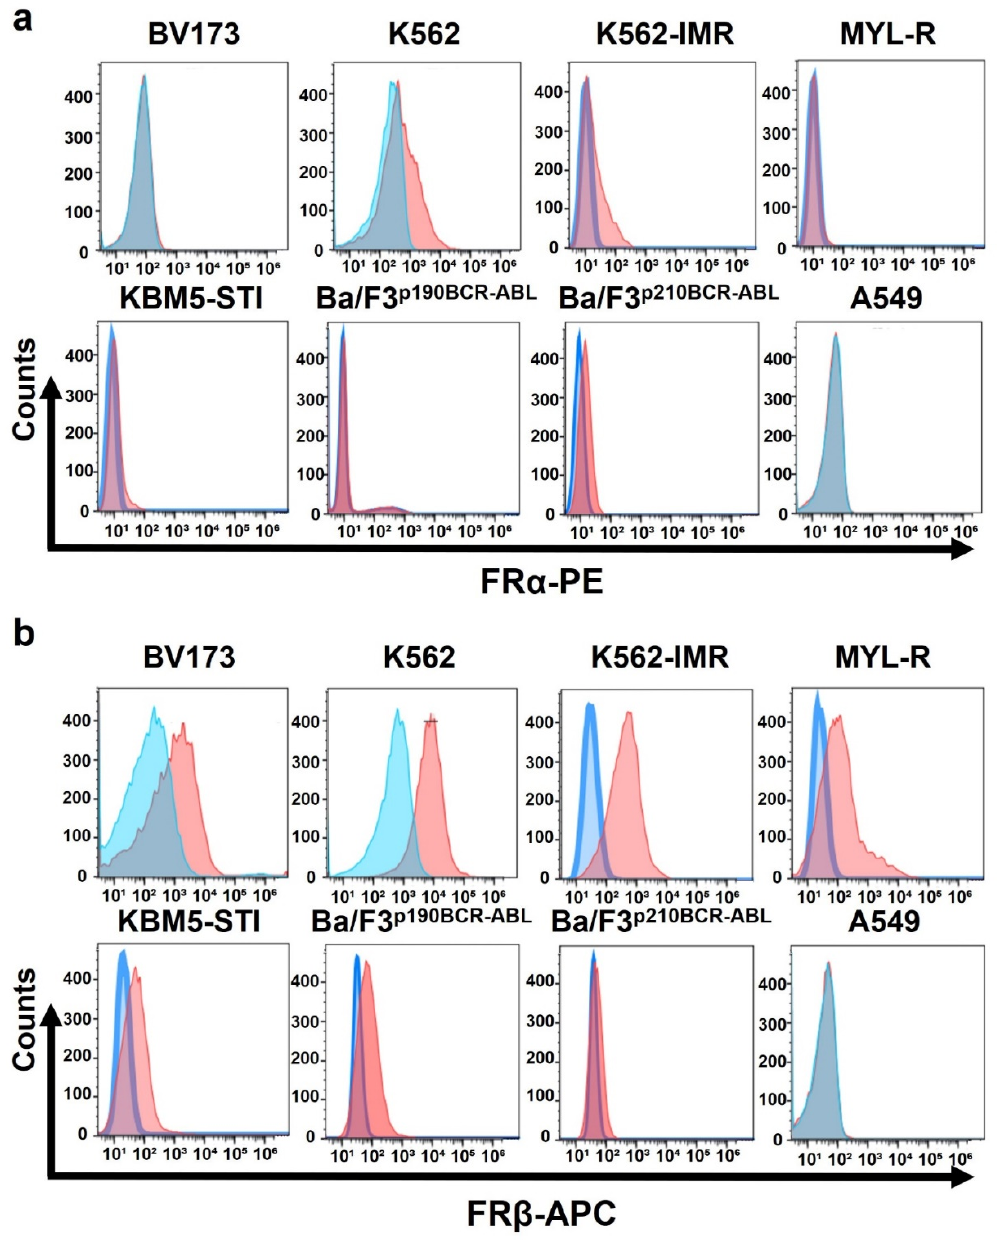
Figure 2. Expression of folate receptors α and β in CML cell lines. ( a ) Folate receptor α (FR α ) expression in CML cells was measured by flow cytometry using FR α -PE antibody. ( b ) Folate receptor β (FR β ) expression in CML cells was measured by flow cytometry using FR β -APC antibody. Blue: control; orange: stained sample with anti-FR α or FR β antibody.